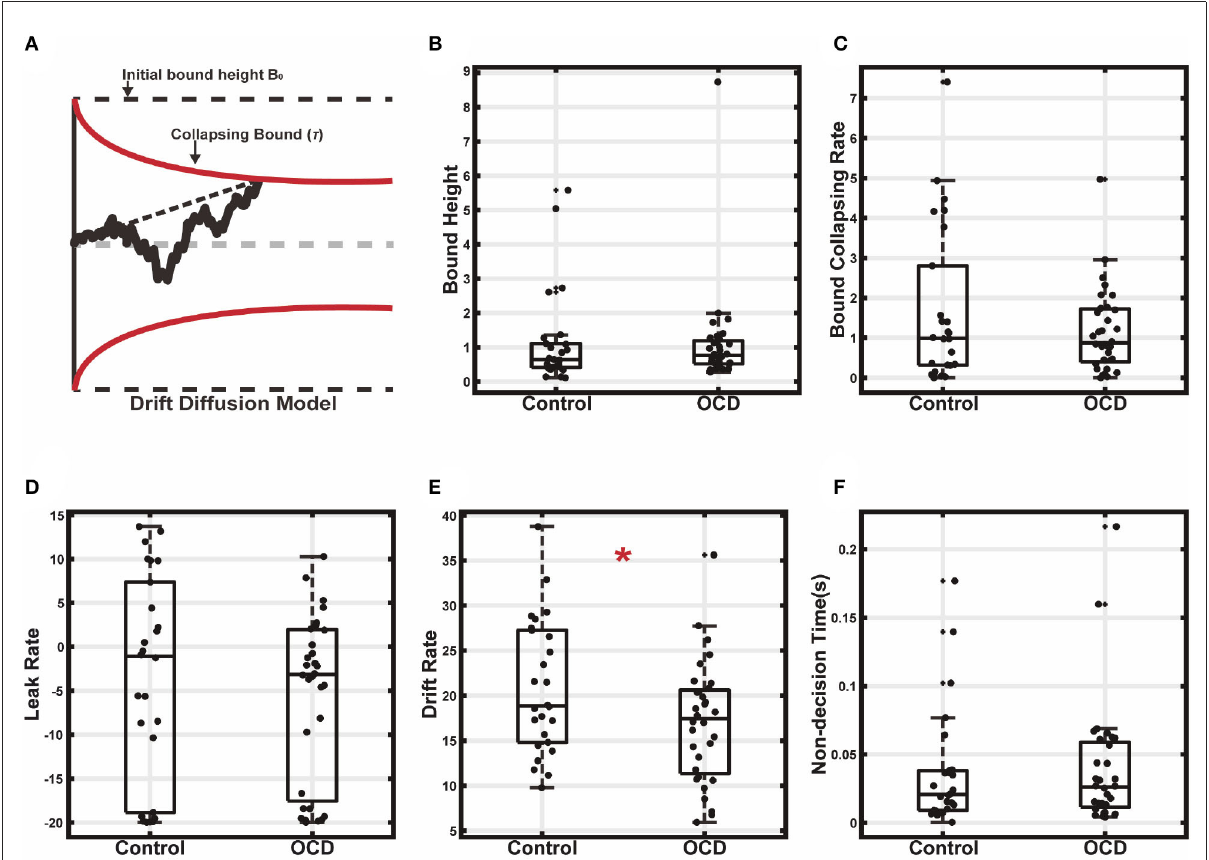
FIGURE4 Drift diffusion model fitting. (A) The decision making was modeled as a leaky drifting process toward symmetric collapsing bounds. (B) Initial bound height. (C) Bound collapsing rate. (D) Leaky rate. (E) Drift rate. (F) Non-decision time (* p <